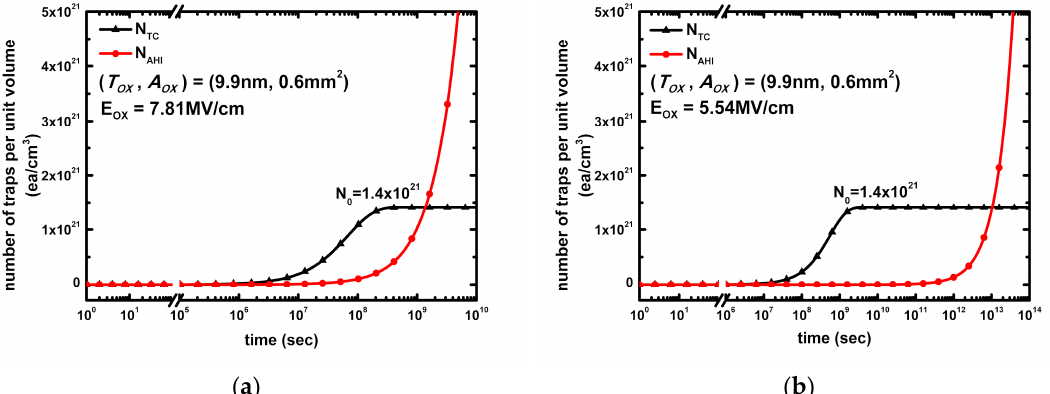
Figure 5. Trap density ( N TC , N AHI ) vs time plot obtained from the proposed TDDB hybrid model: ( a ) Trap density at low temperature (298.15 K); ( b ) Trap density at high temperature (398.15 K).